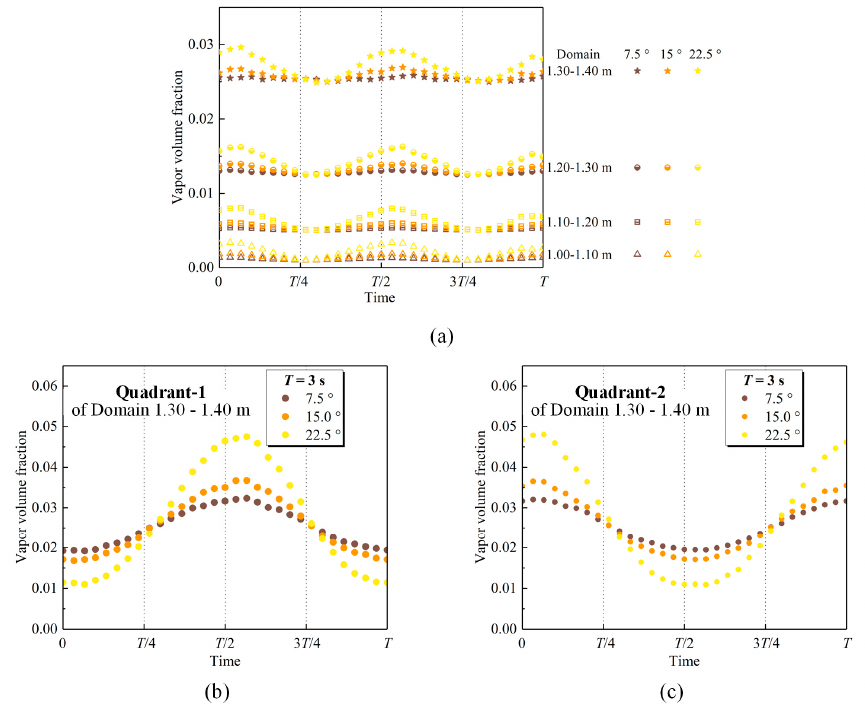
Figure 12. Effect of the amplitude on the vapor volume fraction. ( a ) Domain; ( b ) Quadrant-1 of Domain 1.30–1.40 m; ( c ) Quadrant-2 of Domain 1.30–1.40 m.